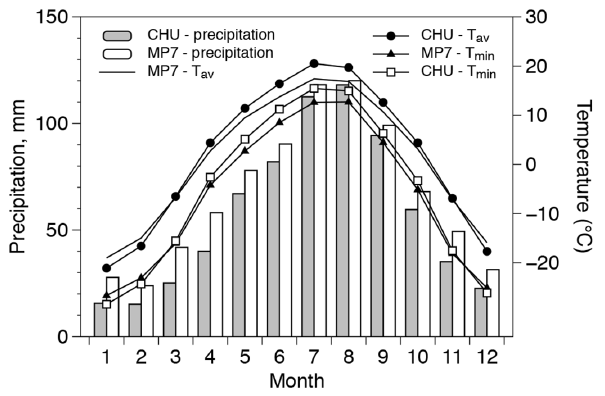
Figure 2. Mean monthly (1936–2004) and minimum temperature (1971–2003) and total precipitation (1936–2004) at Chuguevka and mean monthly and minimum temperature and total precipitation for VUS meteorological station (MP7; 1966–2000).